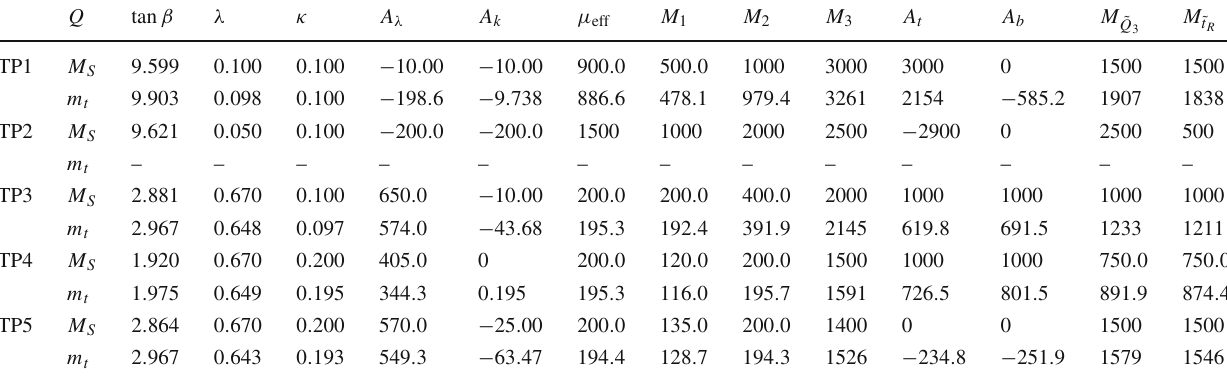
Table 2 Definition of the TP scenarios. All parameters are given as DR parameters at the indicated scale Q . All dimensionful parameters are given in GeV. The remaining parameters, common to all points, are the soft SUSY-breaking parameters in the sfermion mass